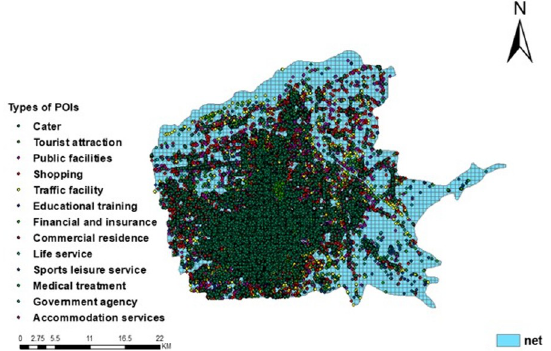
Fig 7. The spatial distribution of 13 categories of POI data.